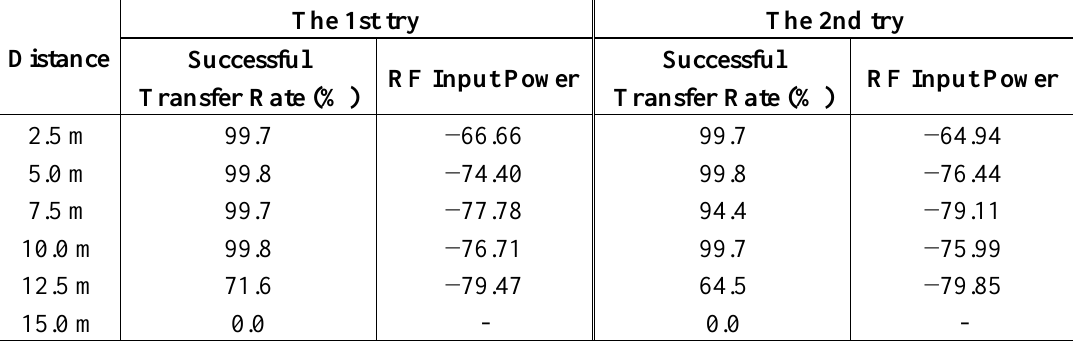
Table 2. Successful Packet Transfer Rate according to